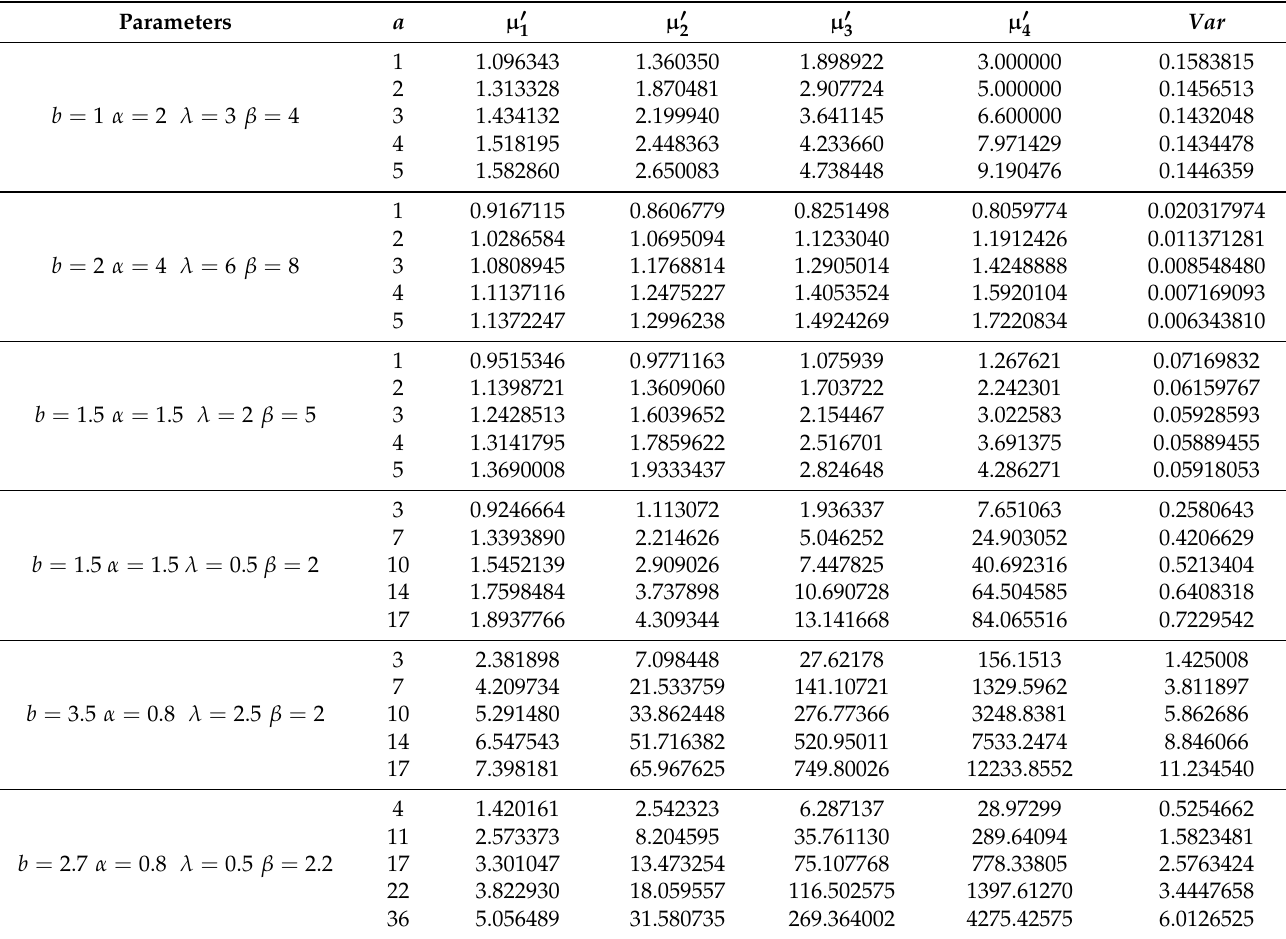
Table 1. Moments about the origin and variance with different parameter values of the KPL distribution.